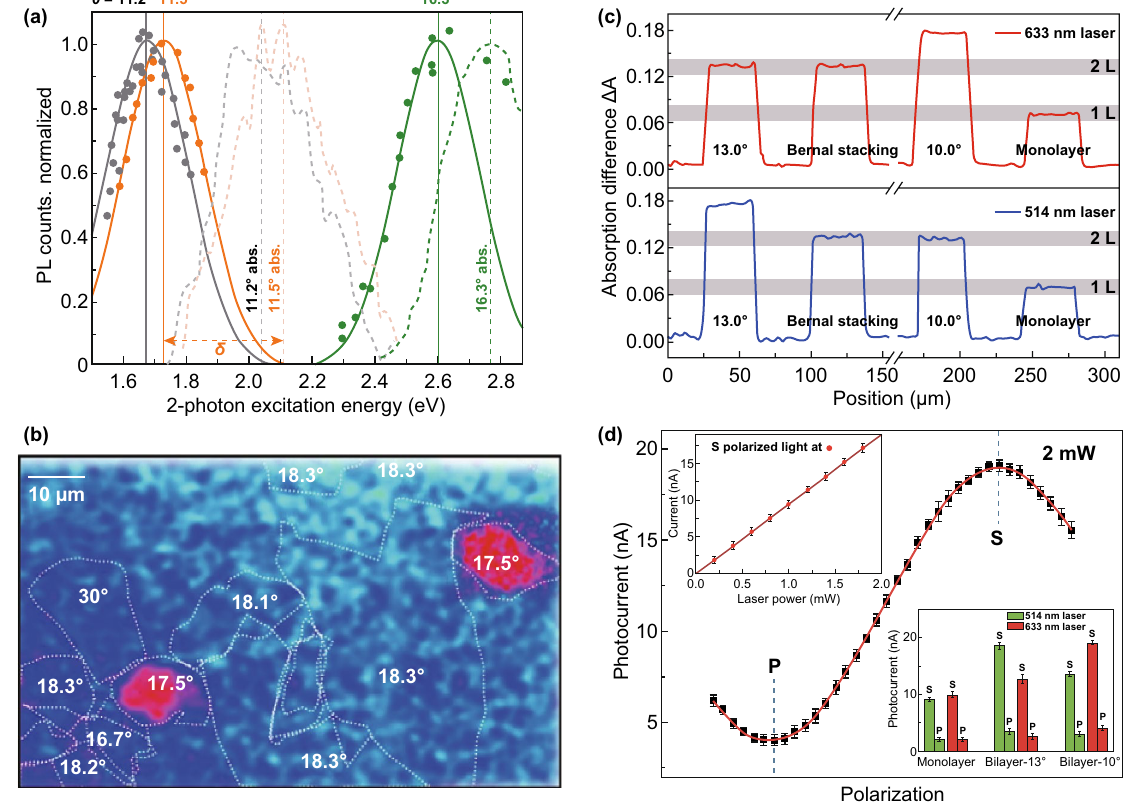
Fig. 6 a PL excitation peaks tune with θ = 11.2°, 11.5°, and 16.3°. b Scanning PL map of tBLG collected at 1.26 eV excitation [130]. c Line scanning results of the graphene films for different laser energies. d The relationship between the incident light polarization and photocurrent and the upper inset image demonstrates the different laser powers and detected photocurrent, the photocurrent of the samples with different twist angles in the lower inset [81]. Adapted with permission from Refs. [81,